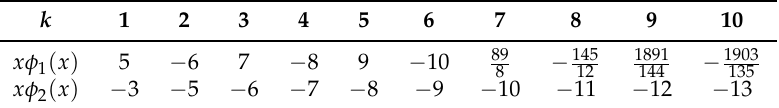
Table 5. The differential transform of x φ i ( x ) , i = 1,2 for Example 7. k